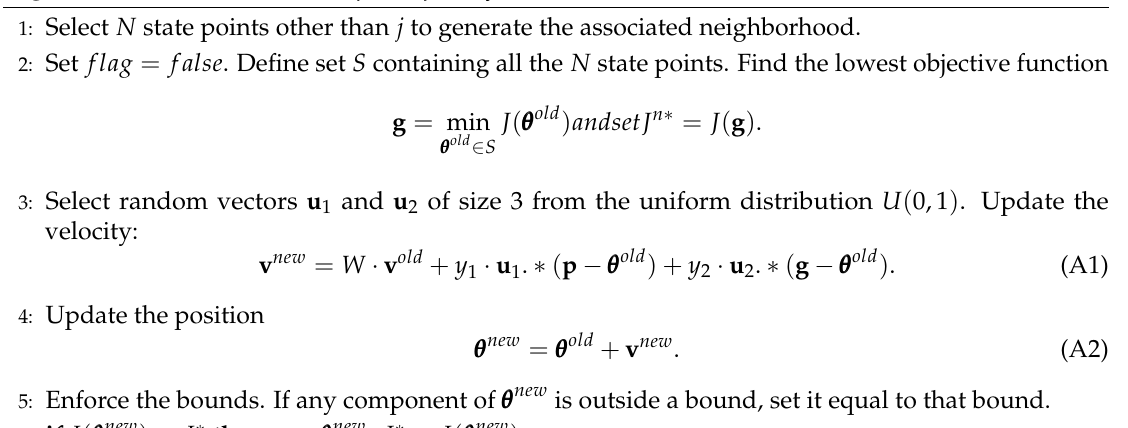
Algorithm A2 Particle Swarm— jth